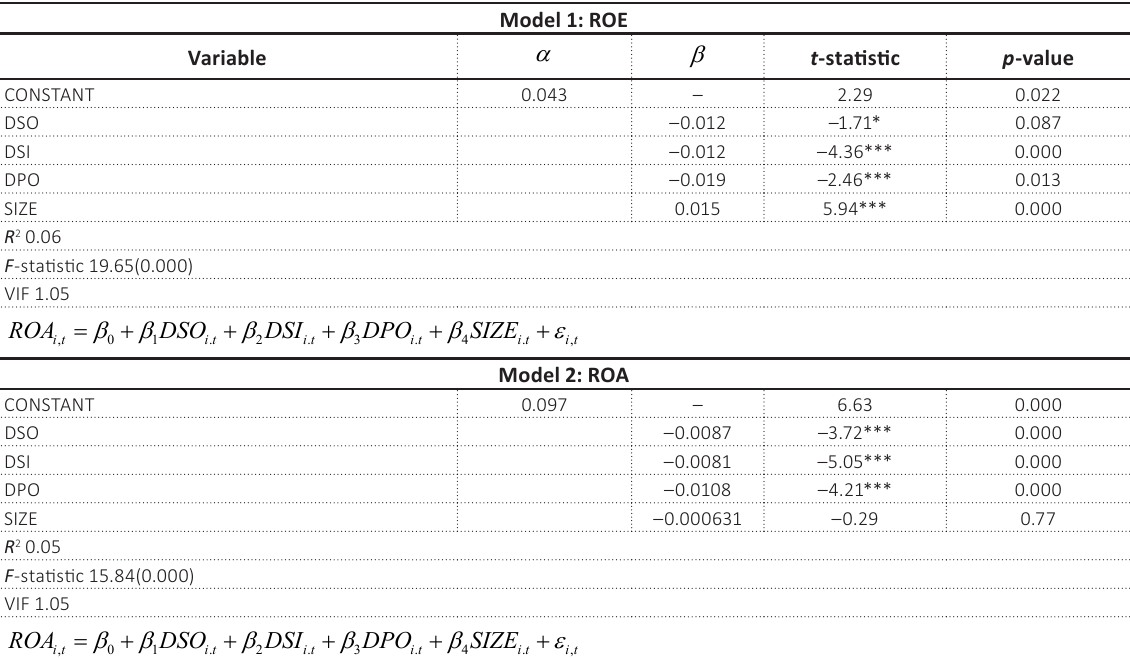
Table 4. Result of regression